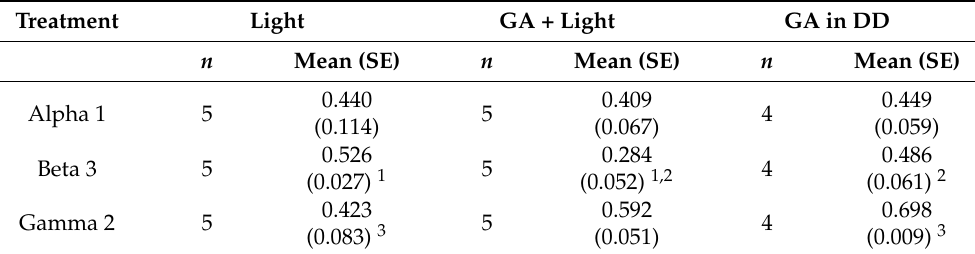
Table 3. Summary statistics of GABA A R subunit expression during late circadian times at which phase shifts due to light and GA are maximal (CT9–CT13). Evidence of differences between treatment groups was tested using ANOVA. Different treatments that share the same superscript number indicate the difference between them is statistically significant (Tukey’s HSD p <